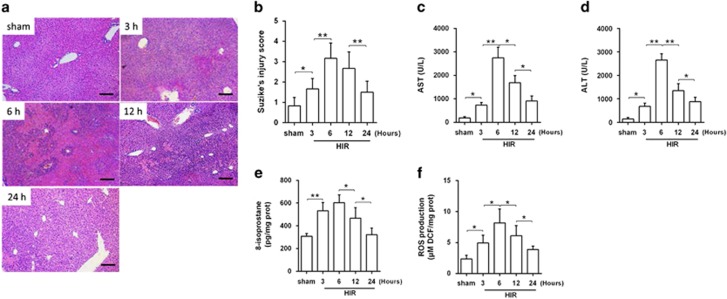
HI/R-induced liver damage. Animals were subjected to 70% liver warm ischemia for 60 min (min) and live tissues were collected at indicated time points. (a) Liver pathology was detected by H&E staining of liver paraffin sections. Representative H&E staining images are shown. (b) Suzike’s injury score was used as criteria to evaluate the injury degree of liver injury. (c and d) Liver function was evaluated by detection of serum AST and ALT concentration. (e) ELISA analysis showed 8-isoprostane level was elevated in response to HIR injury. (f) ROS production in liver after HIR was measured by fluorescence intensity of DCF using a fluorescence spectrophotometer. Each bar represents the mean±S.E.M. (n=6 per group). *P<0.05, **P<0.01, one-way ANOVA with Tukey test